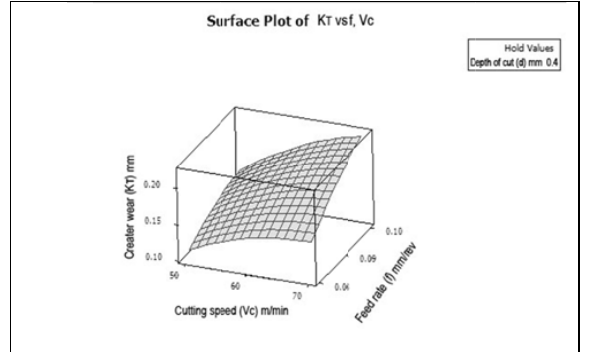
Figure 8. 3D Surface plot of K T vs. f and V c .